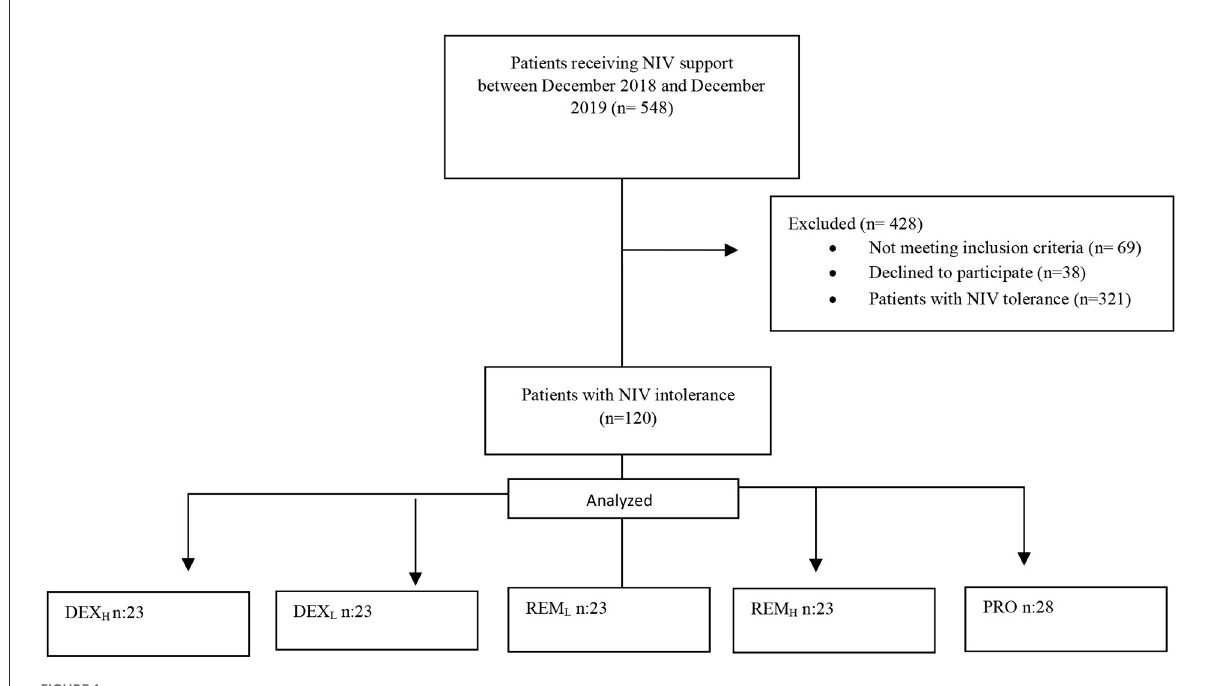
FIGURE1 Study flow diagram. DEX L , Dexmedetomidine low; DEX H , dexmedetomidine high; REM L , remifentanil low; REM H , remifentanil high; PRO,